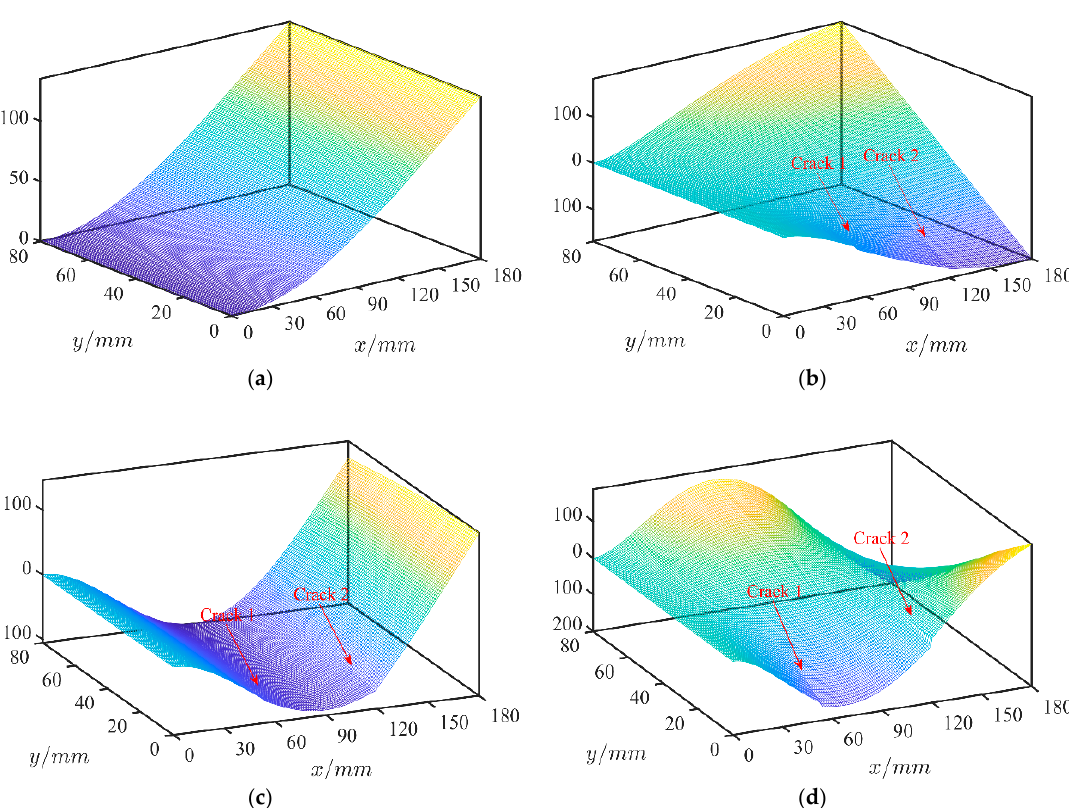
Figure 3. The first four mode shapes of normal translation degree-of-freedoms (DOFs) of the damaged plate model. ( a ) The first mode. ( b ) The second mode. ( c ) The third mode. ( d ) The fourth mode.